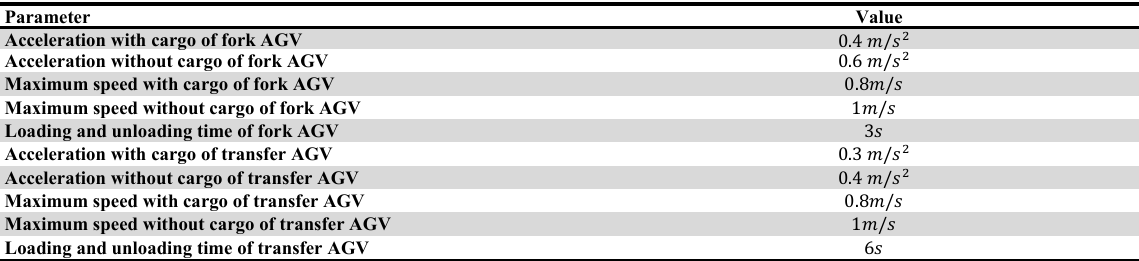
AGVs' Parameters